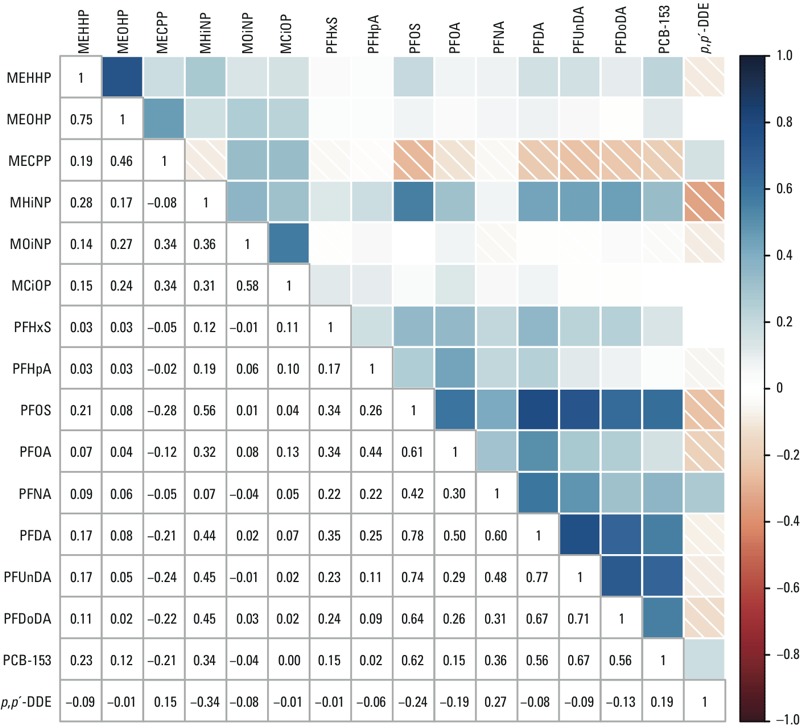
Spearman correlation coefficients between exposure biomarkers. The color intensity of shaded boxes indicates the magnitude of the correlation. Blue indicates a positive correlation, and red with white diagonal lines indicates a negative correlation.